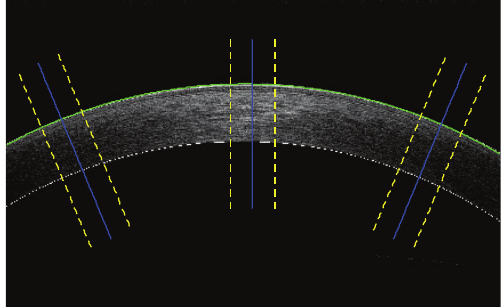
Figure 7: Corneal image of one of the analysed patients with the interpolated air-Epithelium boundary (green curve). Central and midperipheral (nasal and temporal) axes are represented (blue solid lines) together with the delimitations of the three ROIs (yellow dashed lines). The investigated midperipheral angle is 23 degrees in both sides.